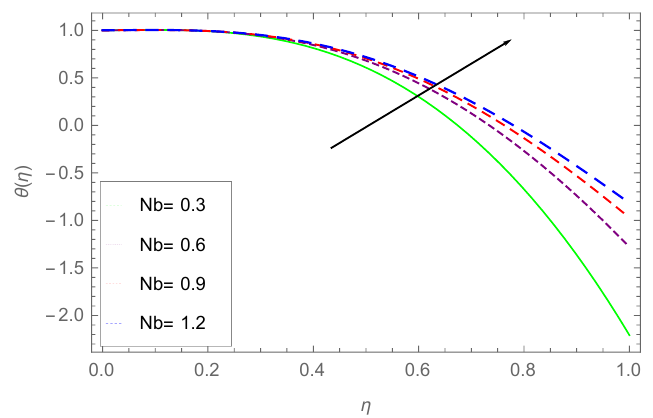
Figure 12. Impact of Nb on θ ( η ) , for St = 0.2, Nt = 0.6, Rd = 0.2, β = 0.1.